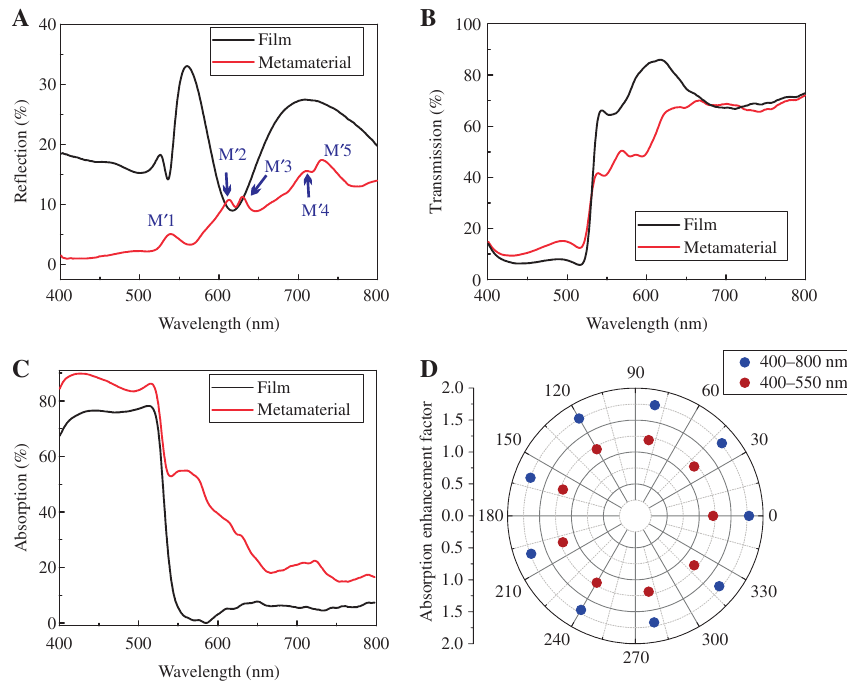
Figure 5: Optical properties measured experimentally. (A–C) Measured reflection (A), transmission (B), and absorption (C) spectra of a metamaterial in comparison with those of the flat film. (D) Absorption enhancement factors of the metamaterial at different light polarizations. The red-colored points represent the absorbable wavelength range (400–550 nm), whereas the blue-colored points represent the entire visible range (400–800 nm). Here, the HOIP metamaterial has t ≈ 280 nm, p ≈ 402 nm, d ≈ 120 nm, and w ≈ 223 nm, while the flat HOIP film has the thickness of 400